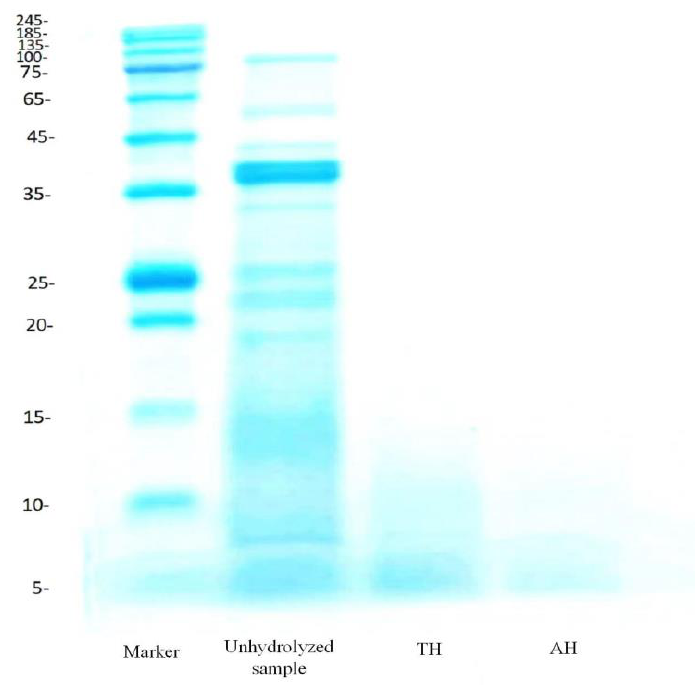
Figure 8. SDS-PAGE analysis on peanut protein and its hydrolysates using alcalase and trypsin.